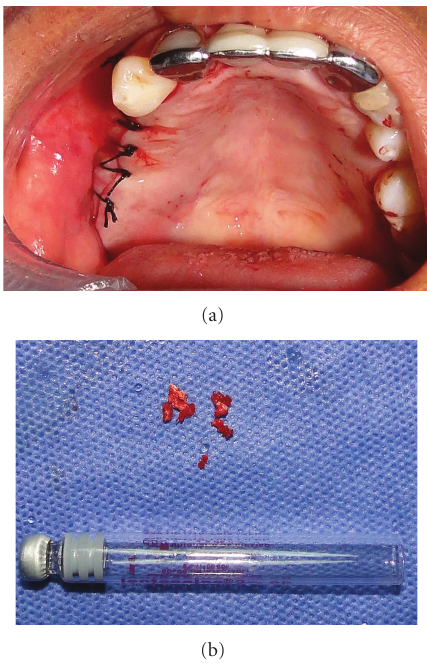
Figure 3: (a) Intraoral supracrestal approach, through which foreign body was removed and incision was sutured with silk 3- 0. (b) Macroscopical view of the foreign body removed, which all together measured 0.7 × 0.5 × 0.2cms.